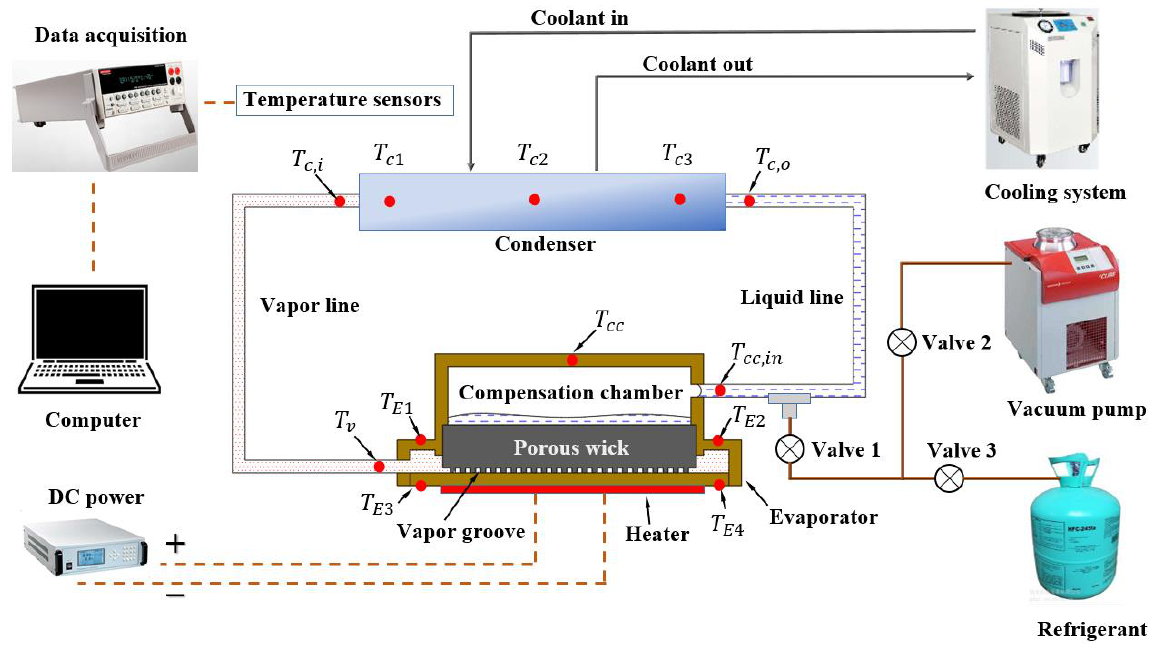
Figure 2. Schematic of the LHP experimental apparatus.